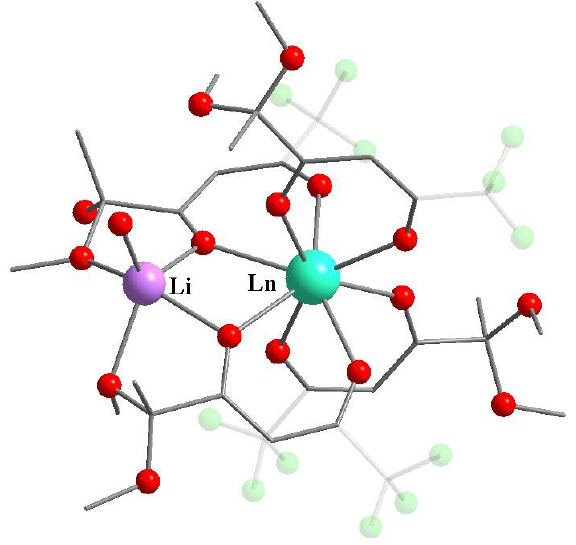
Figure 17. Molecular structure of 35 [87]. Hydrogen atoms, MeCN molecules have been omitted, CF 3 groups are transparent for clarity. The cif has been retrieved from CCDC. CCDC numbers are 1973632 (Ln = Eu), 1973633 (Ln = Tb).